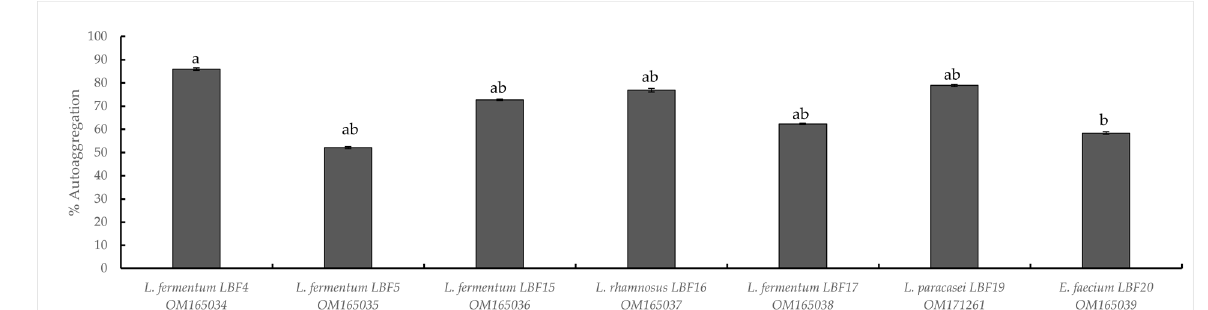
Figure 1. Autoaggregation of LAB strains (as a percentage). Data are expressed as means ± SD. Different letters indicate significant differences of means ( n = 3) based on Tukey’s HSD test at p ≤ 0.05.